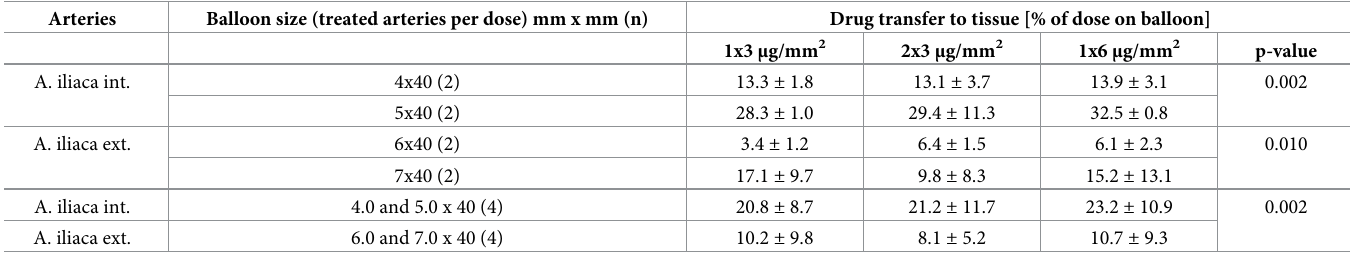
Table 4. Paclitaxel transferred to the vessel wall in % of dose on balloon–summarized for drug doses, balloon sizes and arteries.